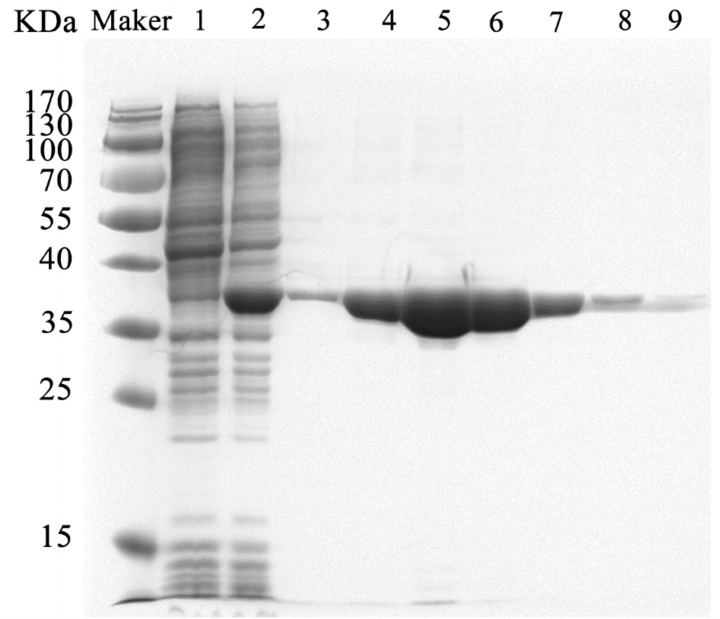
Figure 3. SDS-PAGE gel of recombinant YtnP from E.coli BL21 (DE3). Lanes: M, protein molecular mass markers; 1, cell extract of E. coli BL21 (DE3) that harbored pEASY-Blunt E1 carrying ytnP and that was not treated with IPTG; 2, cell extract of E. coli BL21 (DE3) that harbored pEASY-Blunt E1 carrying ytnP and that was treated with IPTG; 3–9, purified YtnP with different concentration of imidazole elution, 50, 100, 150, 200, 300, 400, 500